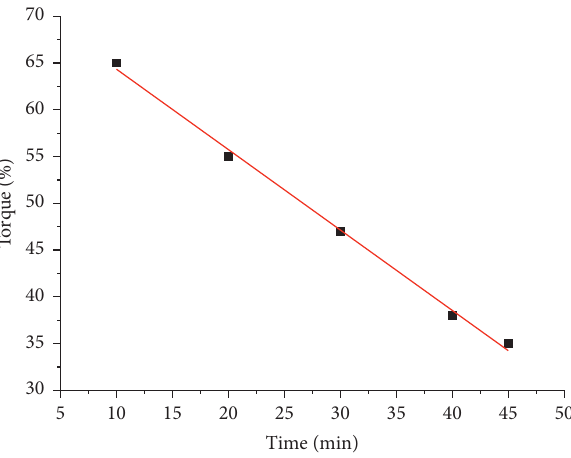
Figure 7: The variation of torque by time.